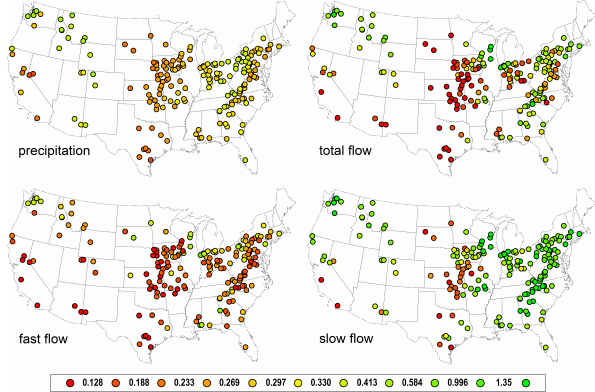
Fig. 6. Regional patterns of variation of parameter κ for the different duration